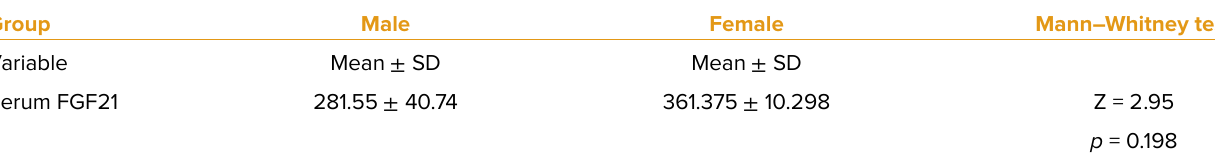
Table 2. Comparison of mean serum FGF21 in patients with pterygium in terms of